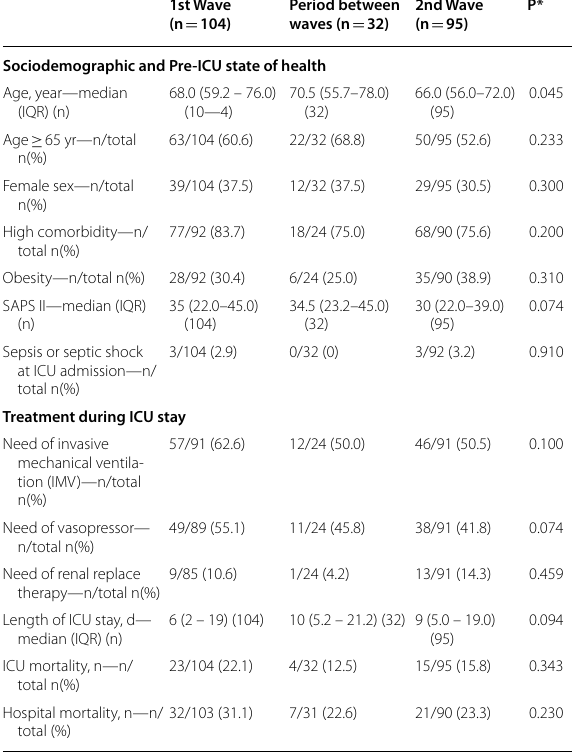
Results. Table 1. Characteristics of patients, treatment and